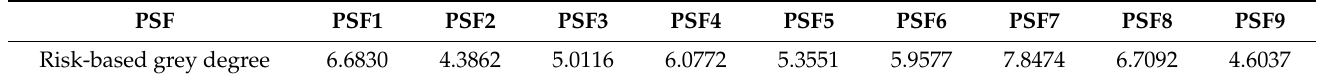
Table 14. The risk-based grey degrees for the PSFs in the whole task.